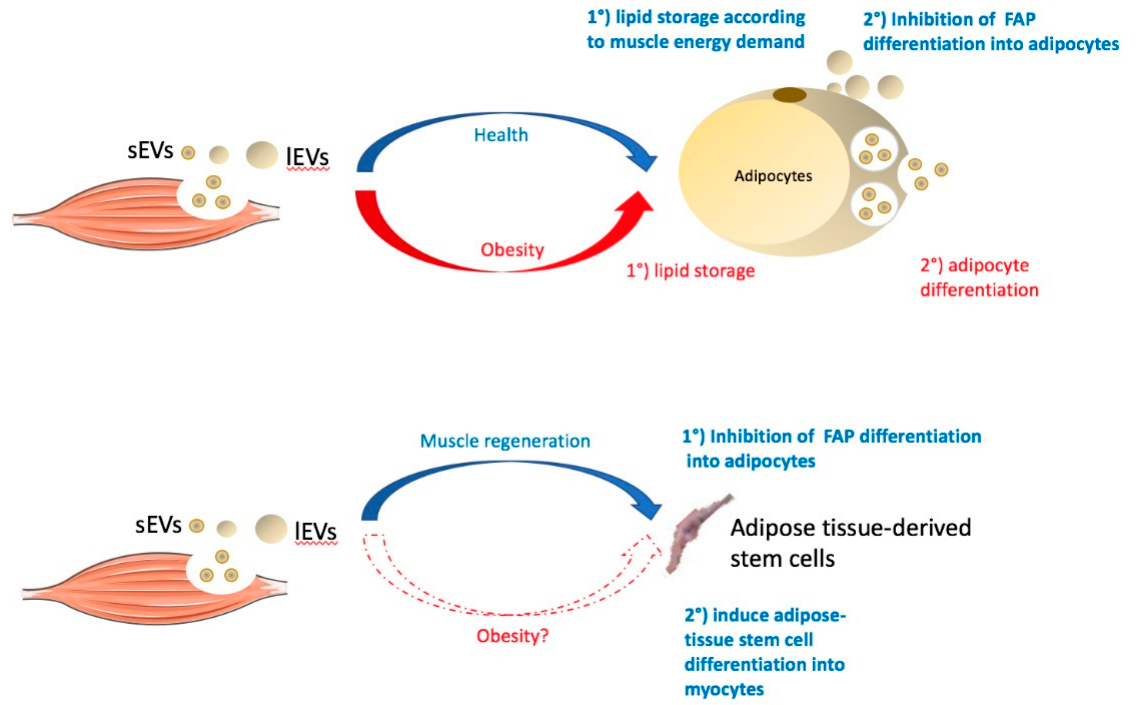
Figure 3. The role of extracellular vesicles released from skeletal muscles on adipocytes or on adipose tissue stem cells in healthy (blue) or obese (red) situations (see below). FAP = fibro-adipogenic progenitor cells; sEVs = small EVs with exosome-like properties; lEVs = large EVs budding from the plasma membrane.